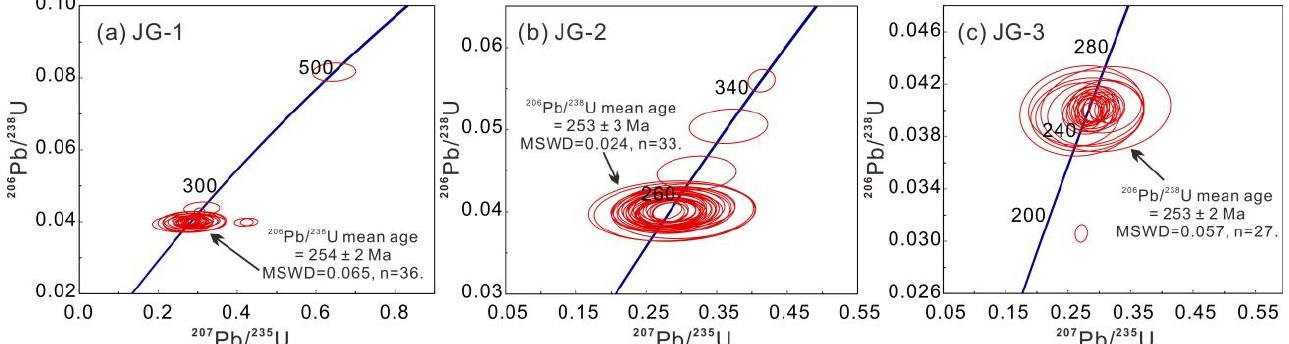
Figure 8. U–Pb concordia diagrams of zircon ages for the granitic pebbles in the conglomerate. ( a ) sample JG-1; ( b ) sample JG-2; ( c ) sample JG-3.